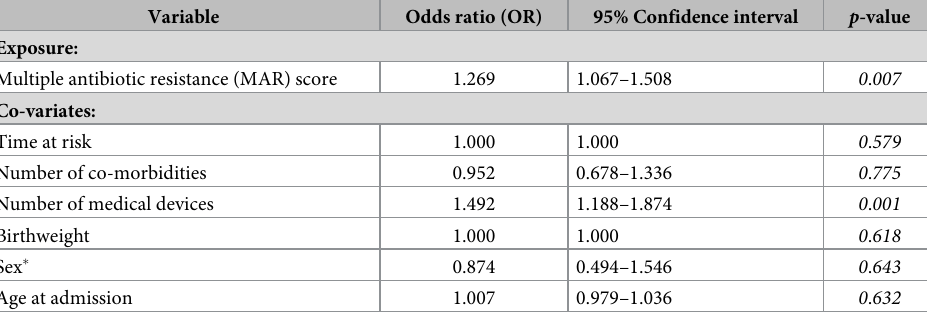
Table 4. Logistic regression model with all-cause mortality as outcome.